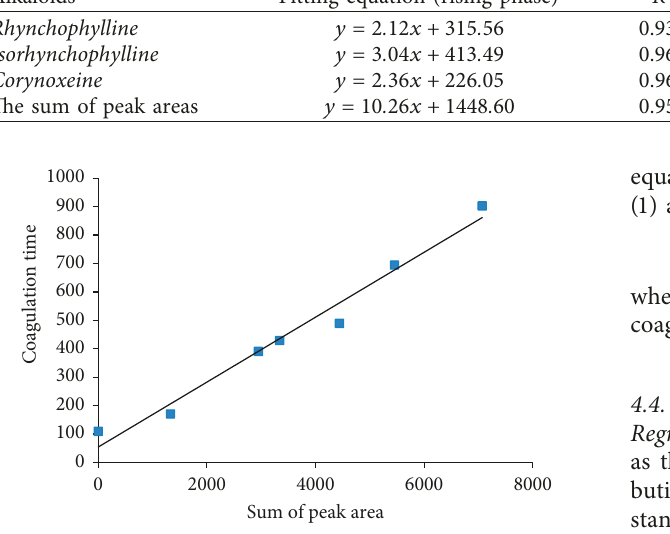
Figure 5: Relationship between peak area and coagulation time of dried